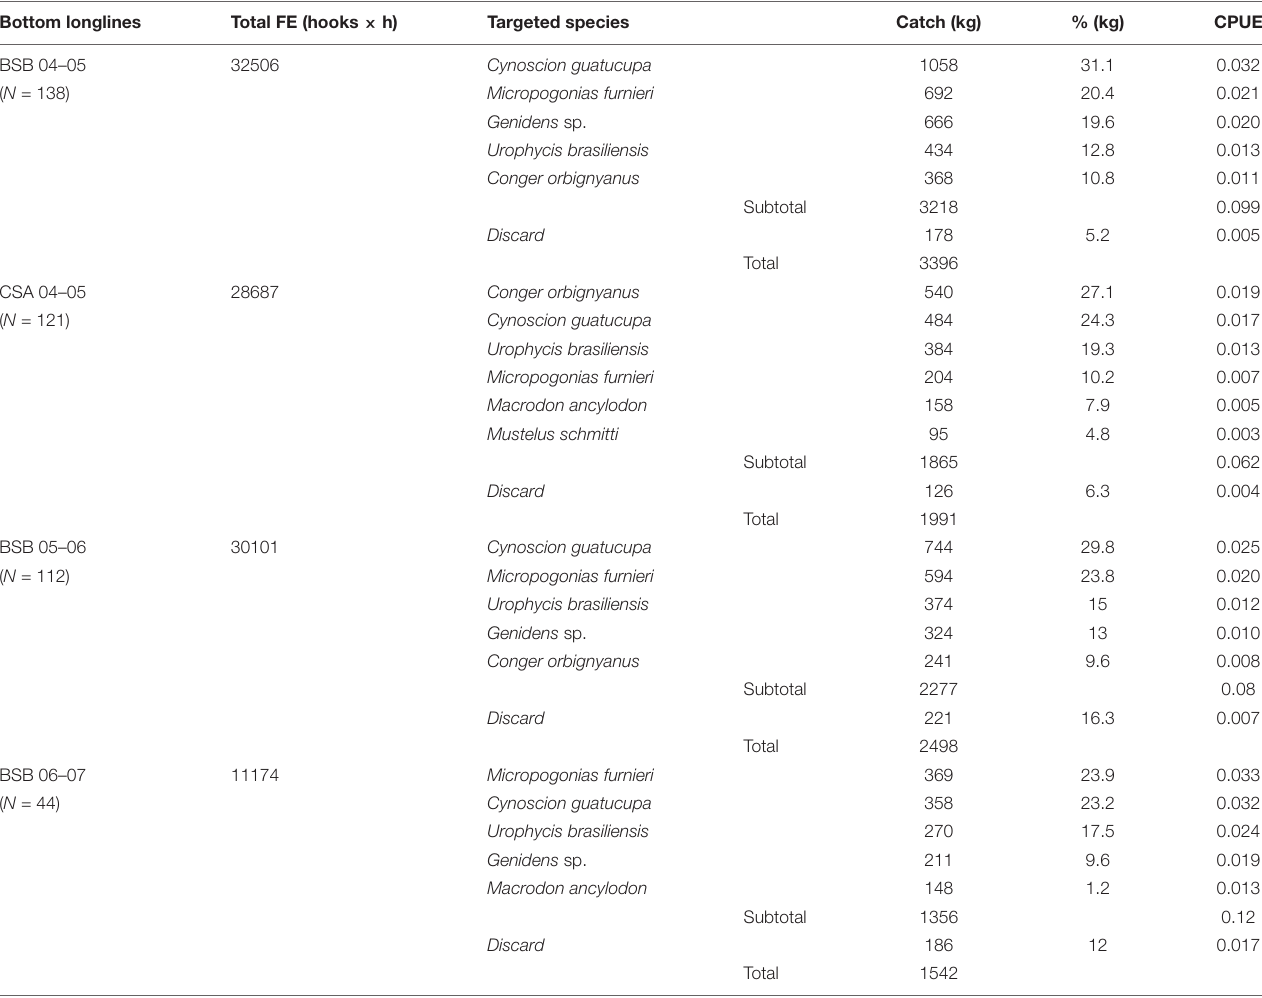
TABLE 2 | Summary of commercial fish catch and discard in bottom longline hauls. Bottom